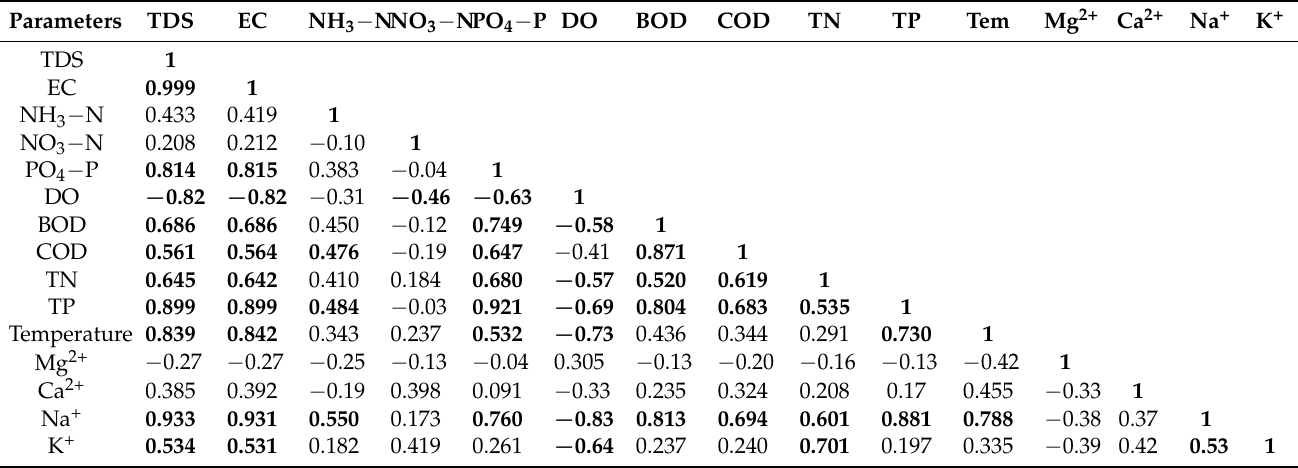
Table 5. Correlation matrix Pearson (r) and alpha (p) values for dry